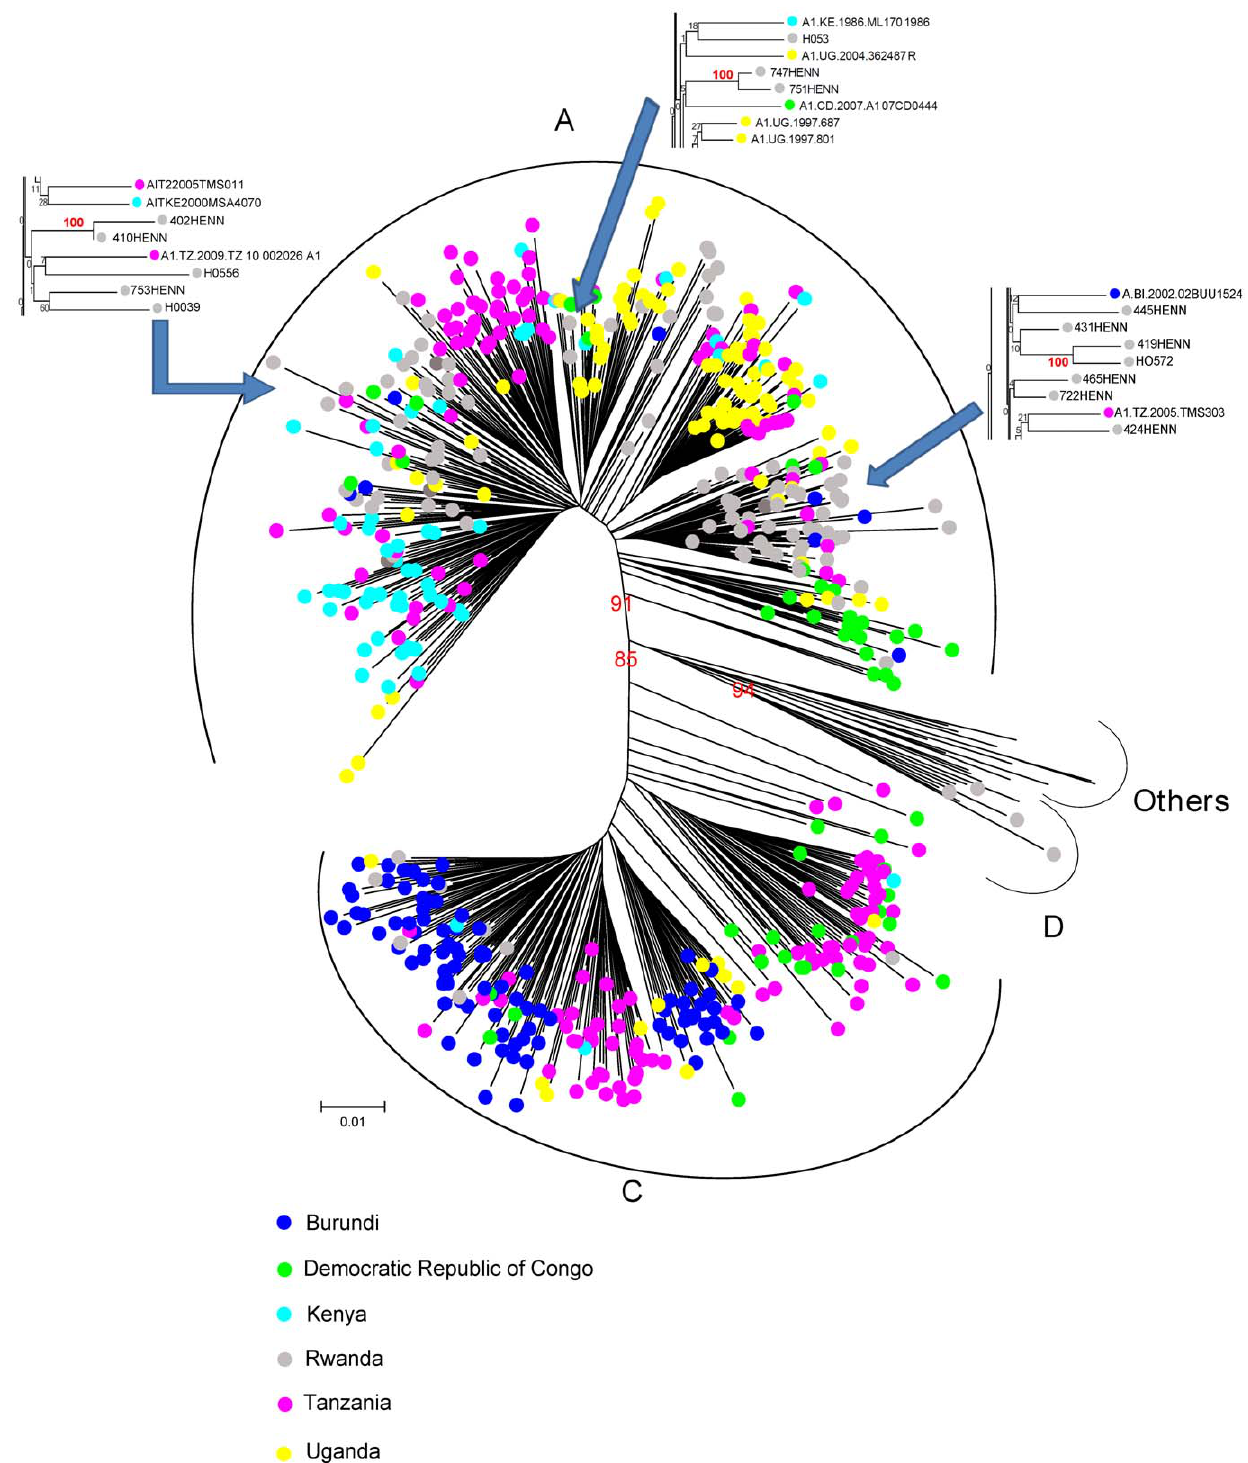
Figure 4. Phylogenetic tree for subtype A1 and C. HIV-1 A1 (N=94) and C (N=8) pol sequences obtained from the Rwandan study participants were analyzed in connection to reference sequences from the Los Alamos database originating from Rwanda (N=4) and the five surrounding countries collected between 1992 and 2009 (272 A1 and 212 C). The four subtype D (analysis 2, data not shown) and the 25 A1/C recombinant sequences were further examined in two separate analyses including 376 subtype D reference sequences and 6 A1/C reference sequences, respectively (analysis 3 data not shown). Country of origin of each sequence is color coded, with Rwanda in grey. The bootstrap values . 85% are indicated in red. Related sequences found within subtype A1 (bootstrap value 100) are shown in detail in the three rectangular phylogenetic tree zoomed inserts.